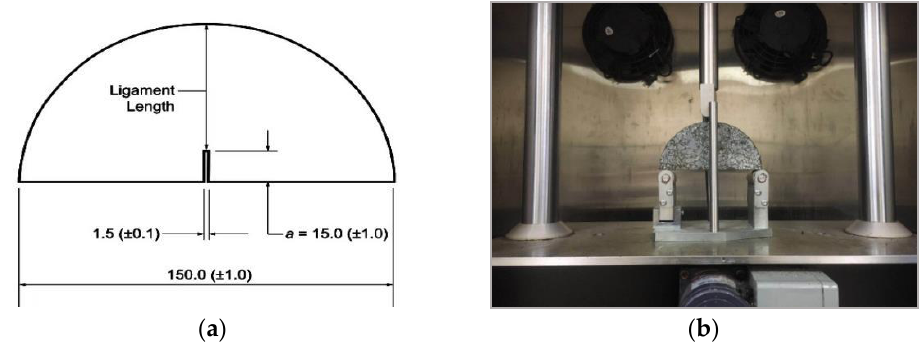
Figure 6. SCB test: ( a ) schematic diagram of pre-cut seam length; ( b ) test photo.